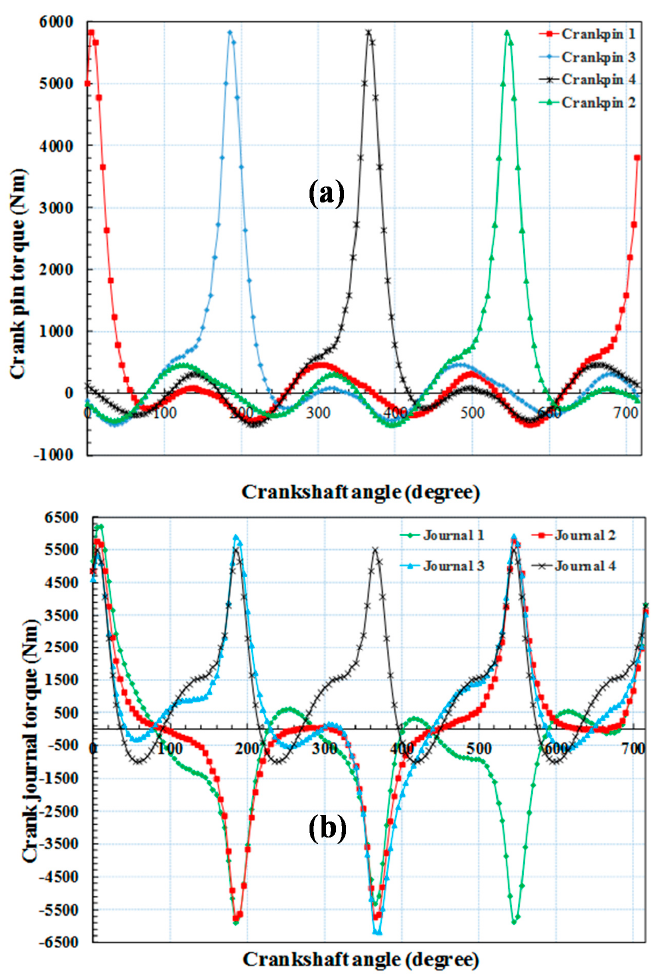
Figure 8. The forces acting on the crankpins and the crank journal of the crankshaft. ( a ) the torque acting on the crankpins ; ( b ) the torque acting on the crank journal